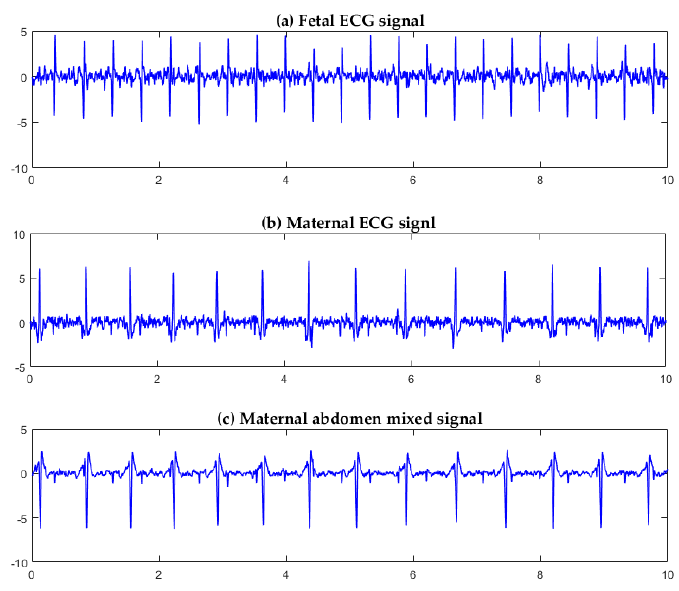
Figure 10. Three source component signals separated by the FastICA algorithm for Ch2, Ch3, and Ch5 signals from the pregnant woman (Figure 8): ( a ) fetal ECG signal; ( b ) maternal ECG signal; ( c ) maternal abdominal mixed signal.